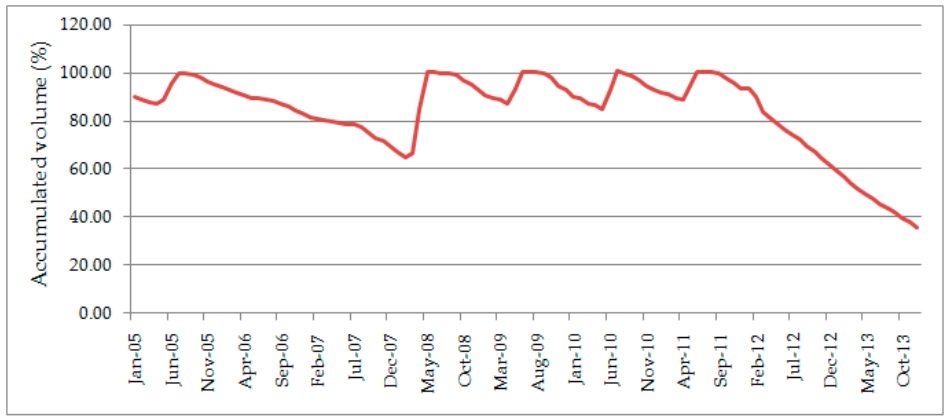
Figure 2. The variation in accumulated volume in Jucazinho in the period from 2005 to 2011. Source: [8].